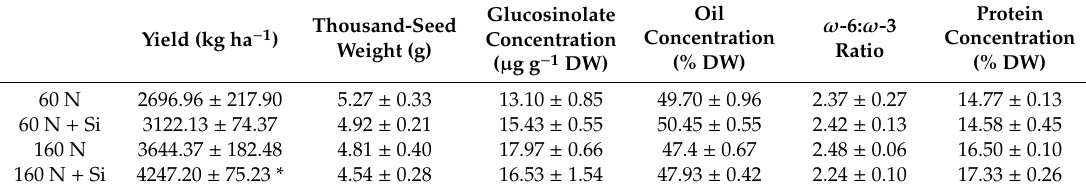
Table 2. Yield component, concentration of oil, protein and glucosinolate concentrations and linoleic acid ( ω -6): linolenic acid ( ω -3) ratio ( ω -6: ω -3 ratio) in mature seeds from rapeseed cultivated with 60